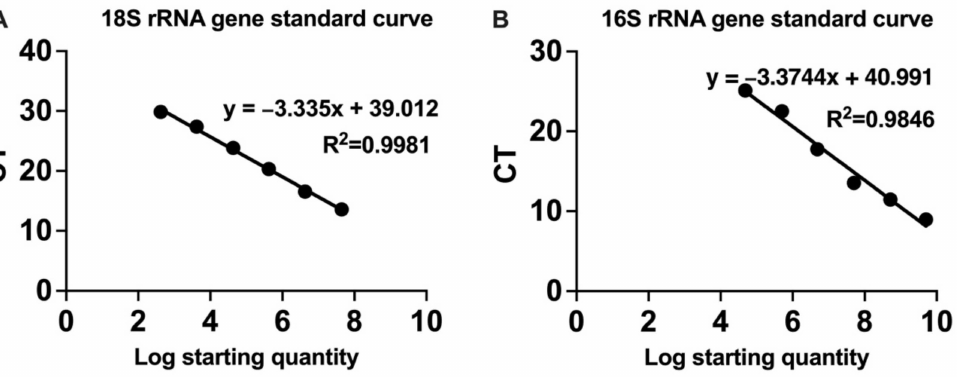
Figure 1. 18S rRNA gene qPCR standard curve ( A ) and 16S rRNA gene qPCR standard curve ( B ).